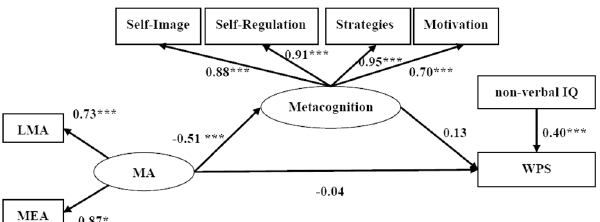
Fig 2. Partially mediated structural equation modeling of mathematics anxiety, mathematical metacognition, and word problem solving with IQ partialled out. MA = mathematics anxiety, LMA = learning mathematics anxiety, MEA = mathematical evaluation anxiety, WPS = word problem solving. * p < .05. ** p < .01. *** p < .001.